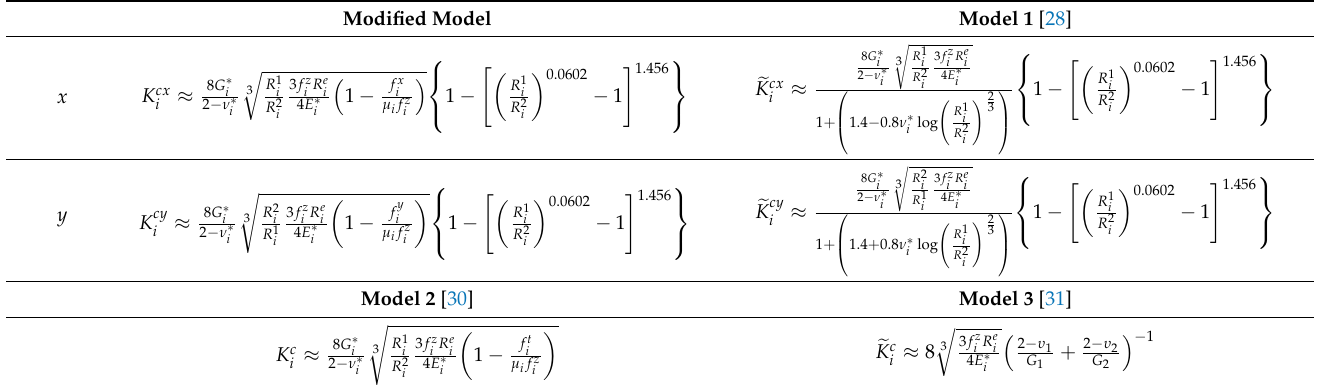
Table 4. The comparison between similar mainstream tangential contact stiffness models. Modified Model Model 1